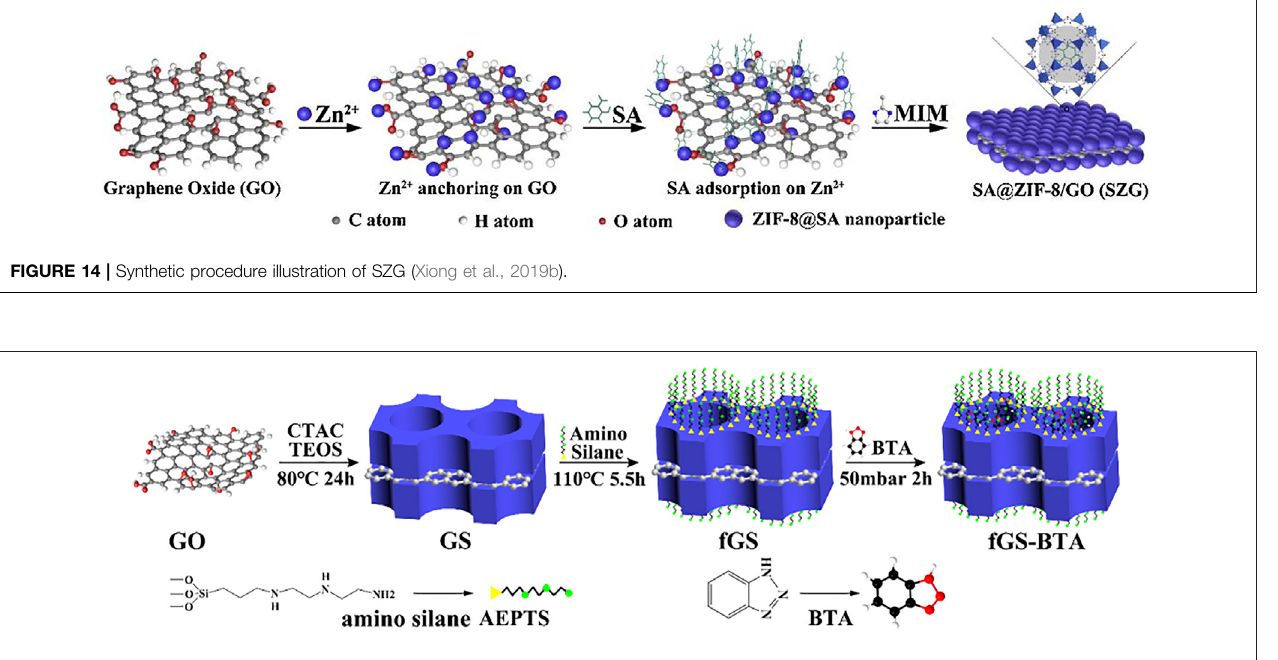
Frontiers in Materials |